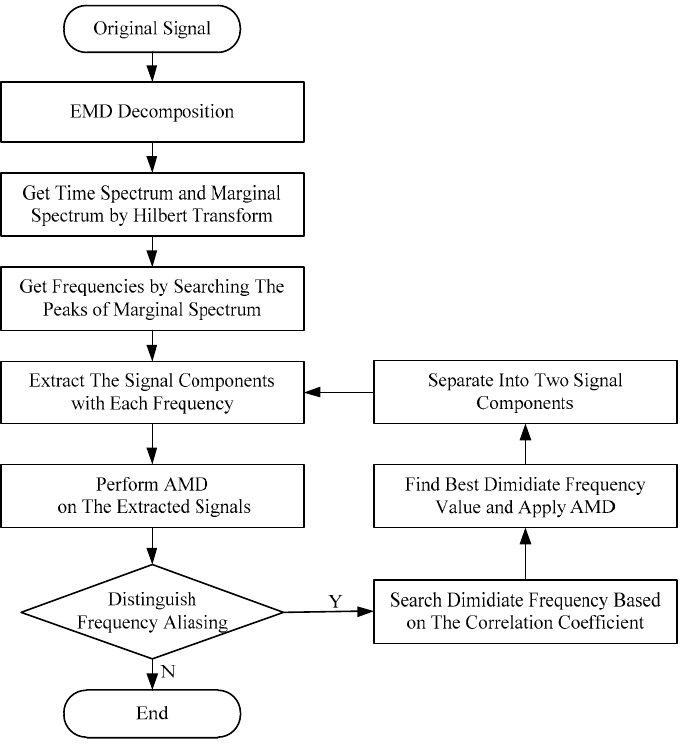
Figure 3. Flow chart of signal decomposition.